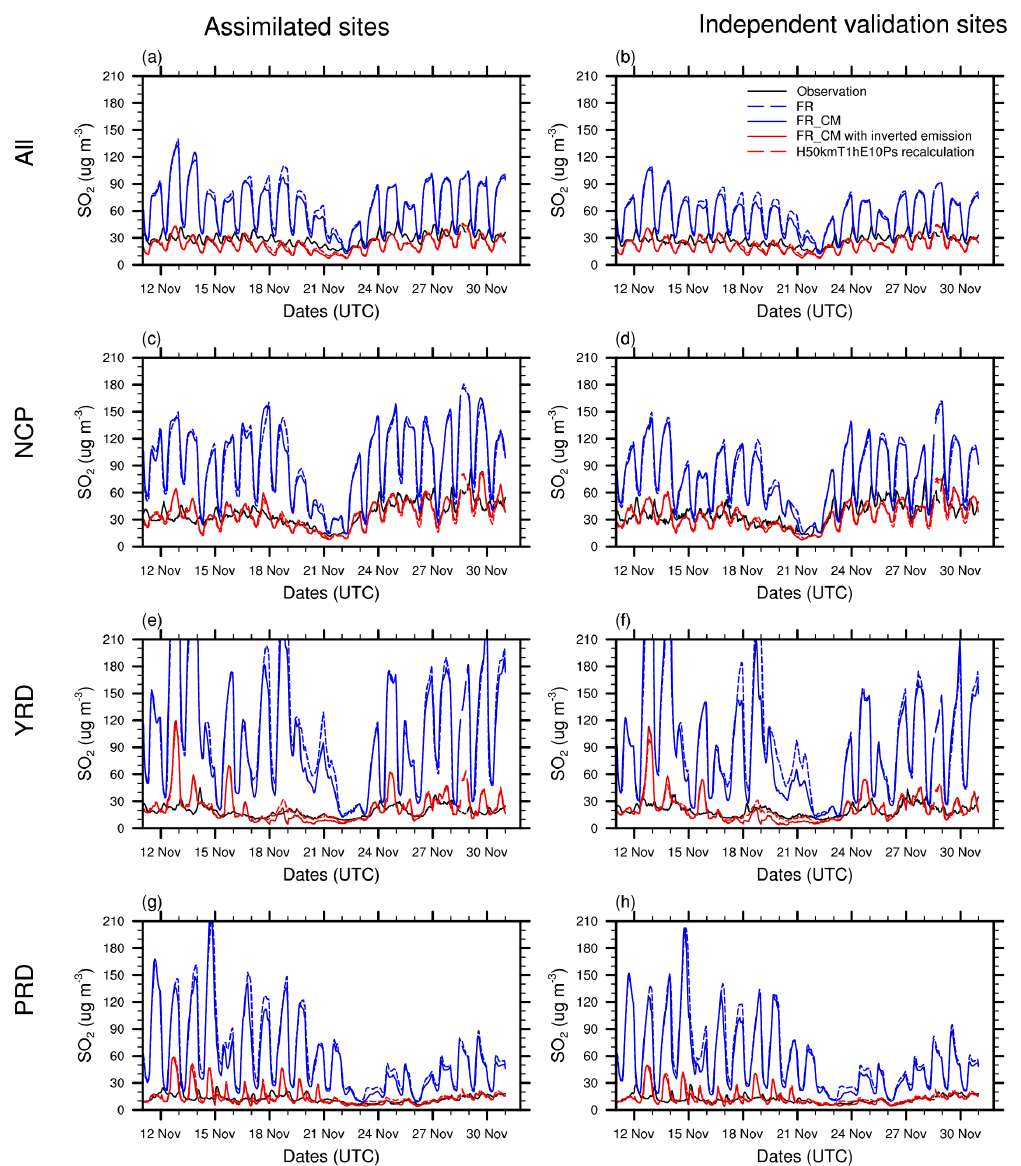
Figure 10. Time series of the simulated SO 2 surface concentrations in various experiments and the CNEMC